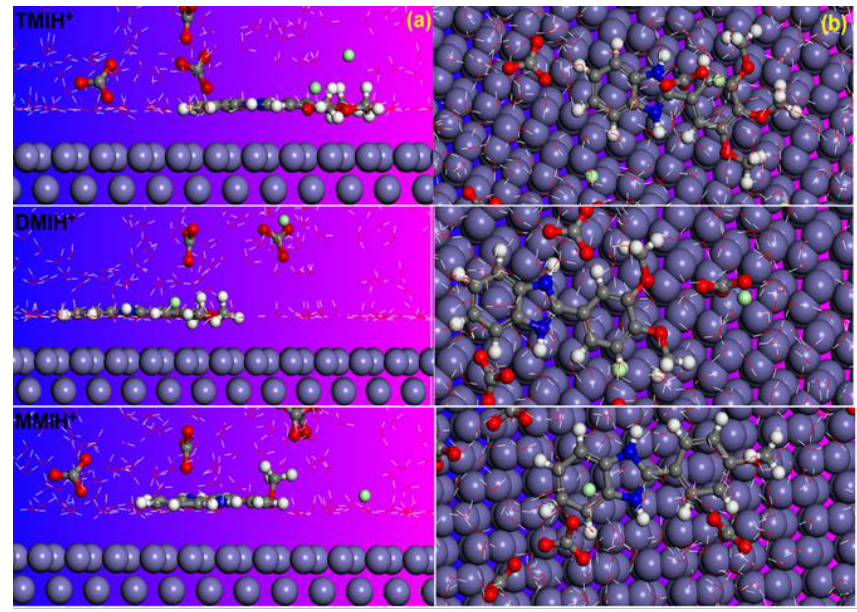
Figure 6. Side and top views of the final adsorption of neutral forms of inhibitor molecules on the Fe (110) surface in solution: ( a ) Side view; ( b ) top view.